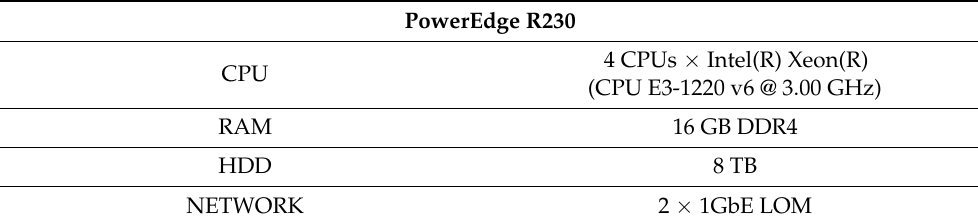
Table 2. Physical Servers technical specifications.